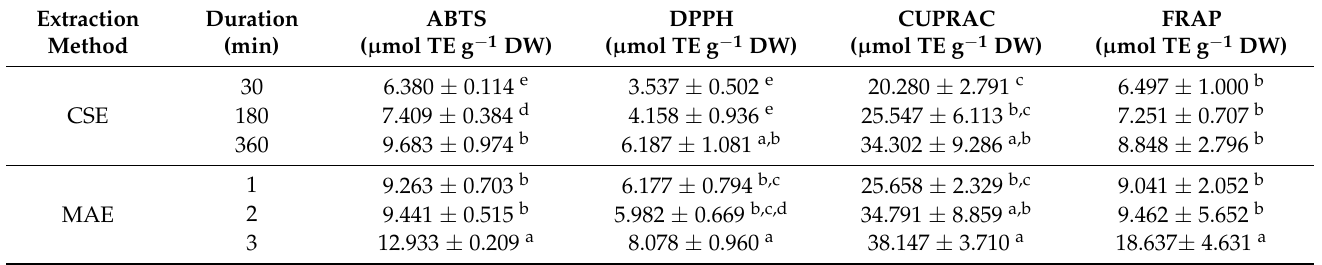
Table 2. Antioxidant activities of methanol extracts of A. compactum measured by different